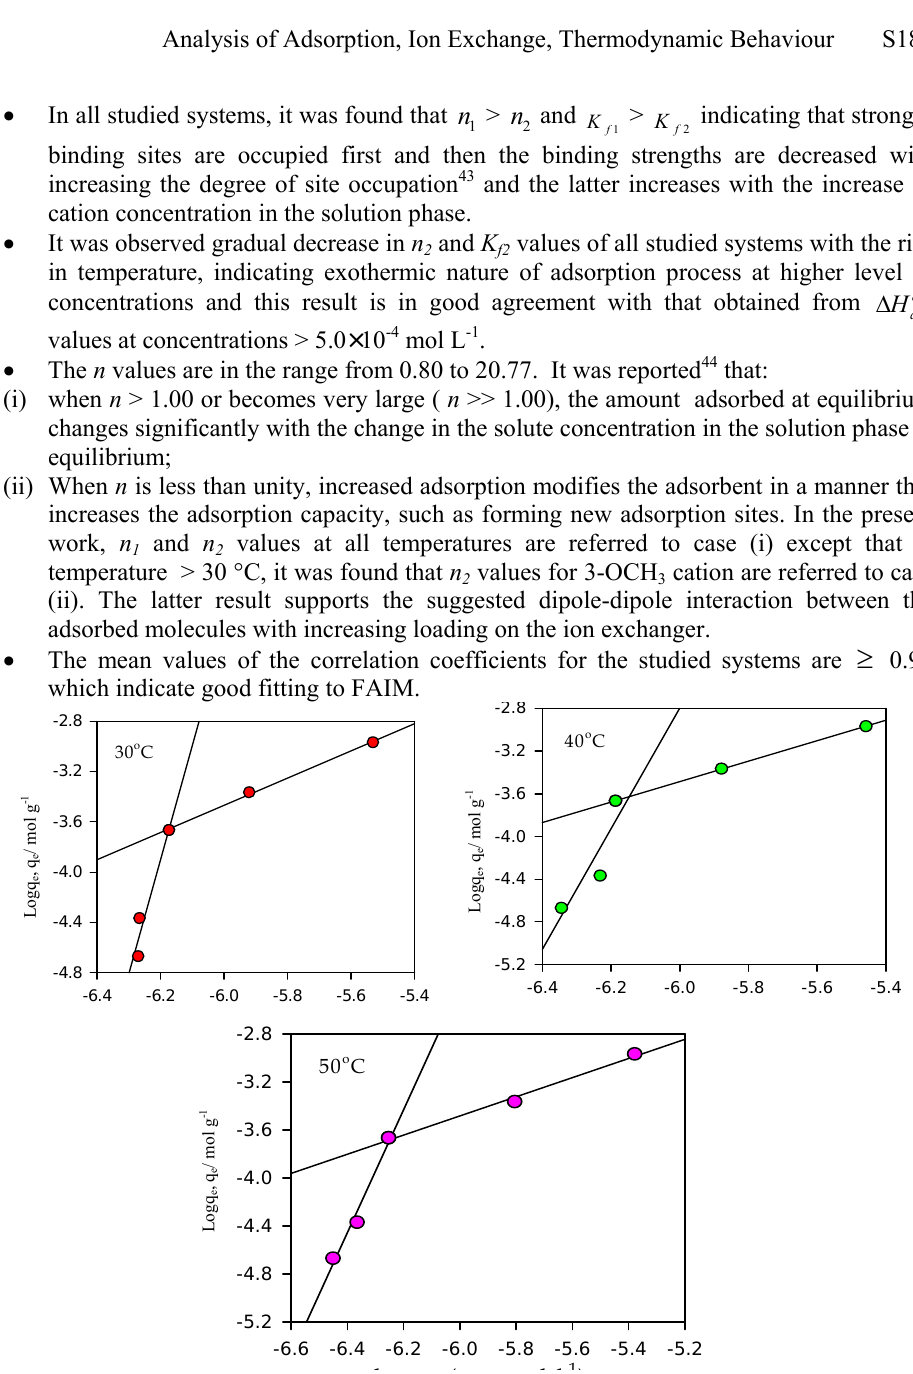
logC e , C e / mol L